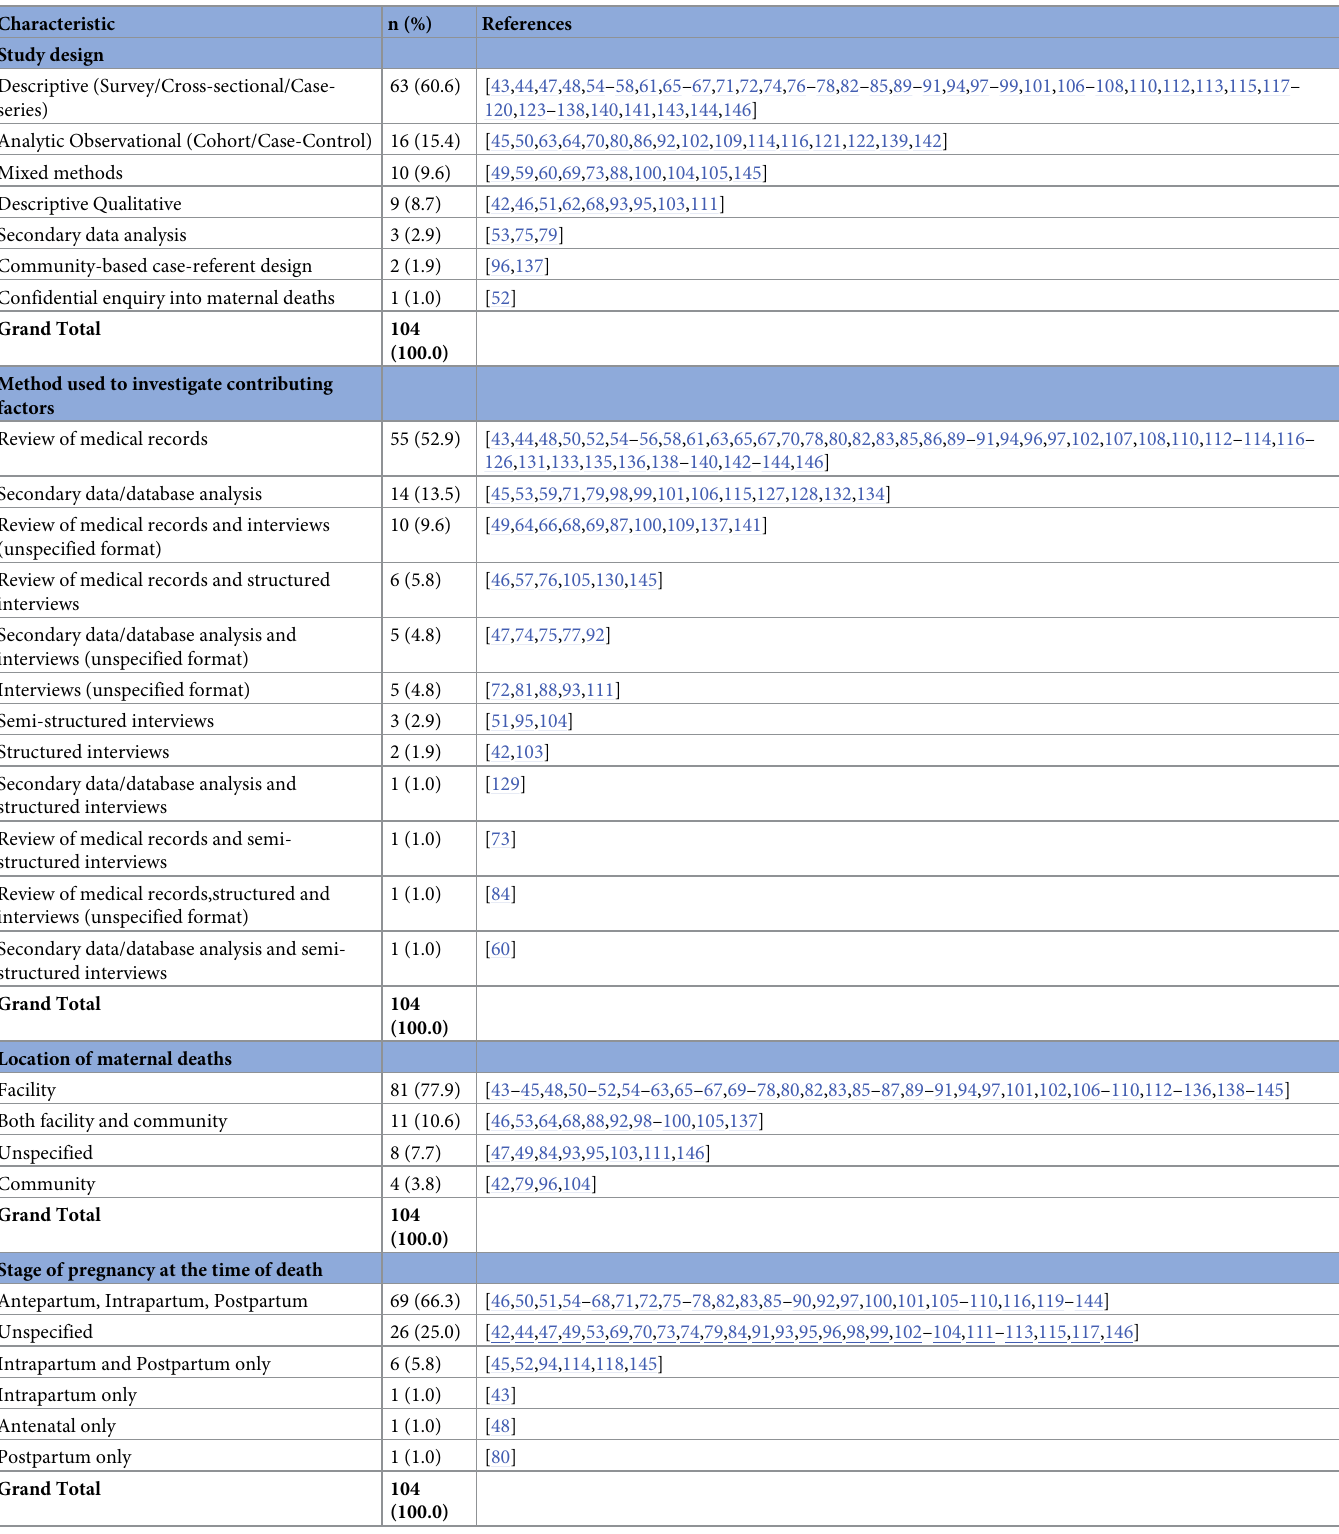
Table 1. Characteristics of included